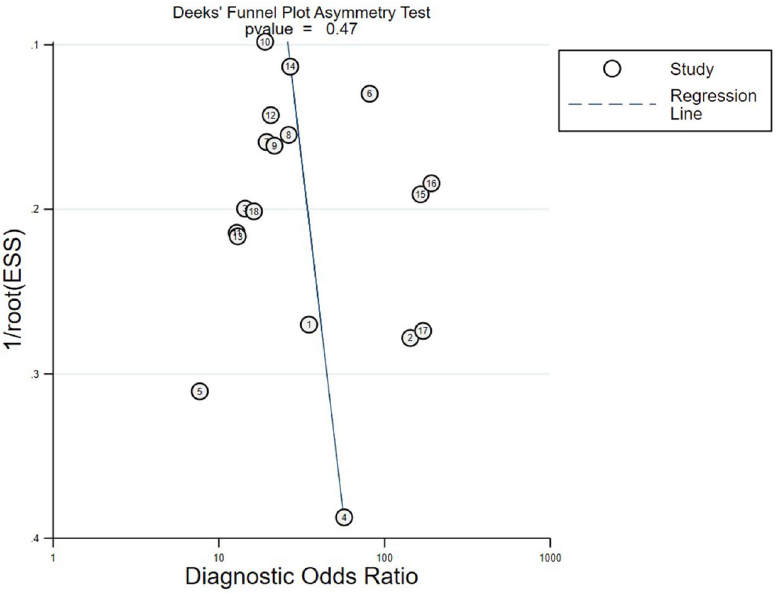
Figure 6. Funnel plot for the evaluation of potential publication bias of selected studies.